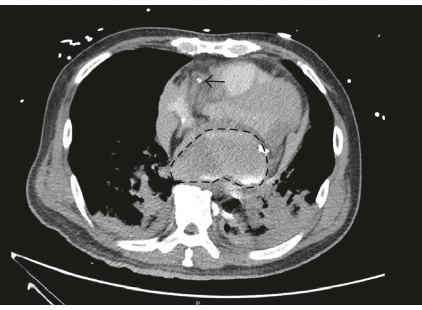
Figure 5: CT chest showing large hematoma arising from atrio- ventricular groove, with contrast from coronary angiogram, compressing on left atrium. The coronary sinus cannot be seen in the scan due to severe extrinsic compression. The arrow shows the ECMO cannula at the superior vena cava and right atrium